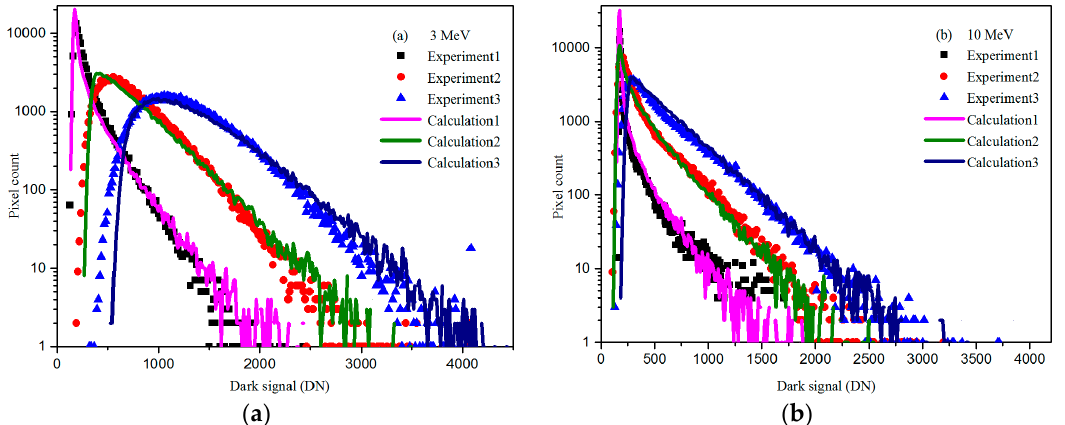
Figure 10. Experimental (point) and calculated (lines) distributions for CISs after proton radiation: ( a ) 3 MeV; and ( b ) 10 MeV.